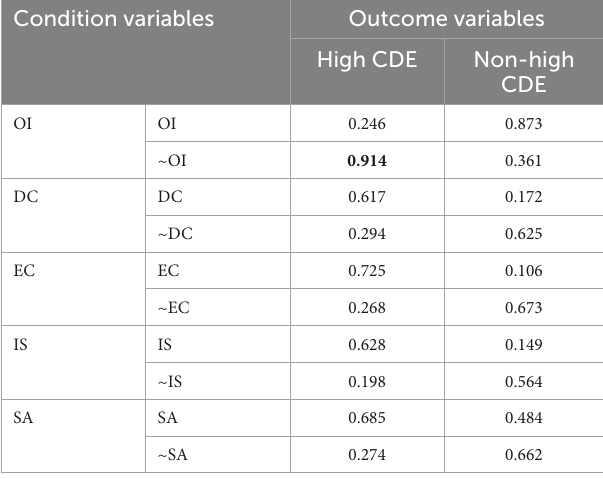
TABLE 7 The analysis of the necessary conditions for CDE.